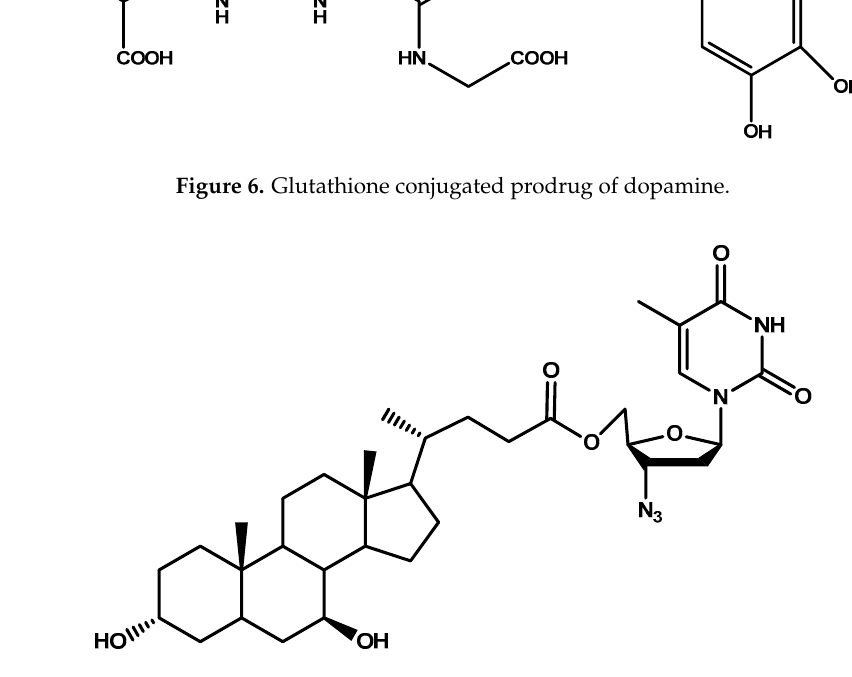
Figure 6. Glutathione conjugated prodrug of dopamine.